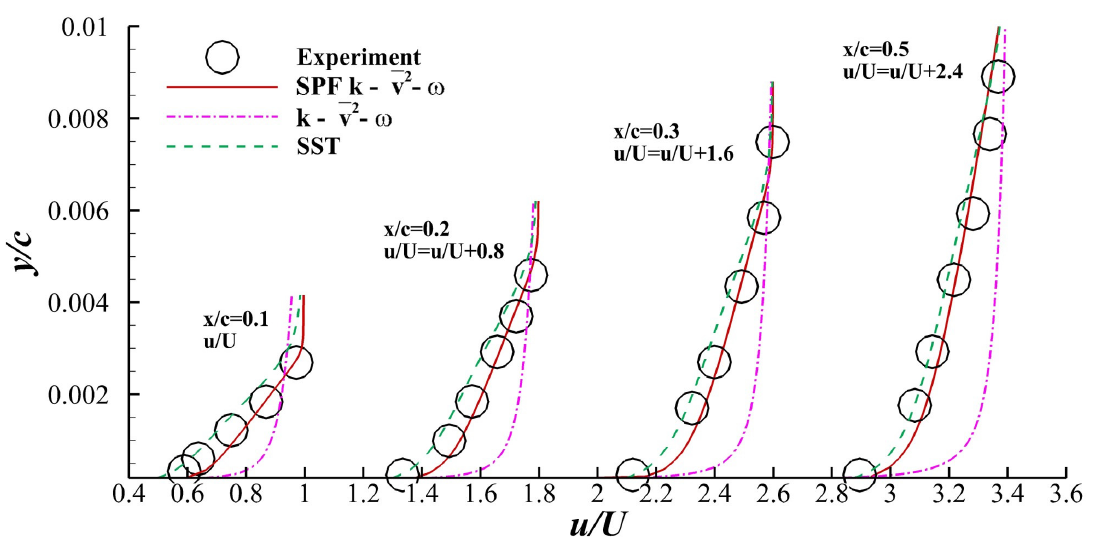
Figure 14. Velocity profiles at AOA = 4 ◦ , Re = 5.8 × 10 6 and Ma = 0.167. The symbols represent experimental data obtained by McCullough et al. [35].